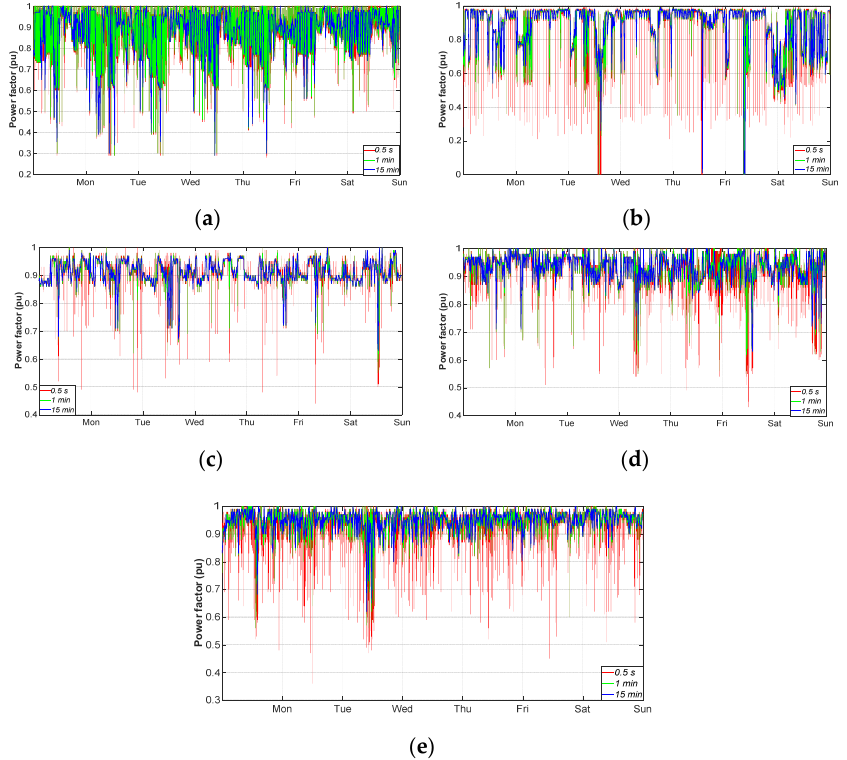
Figure 13. Weekly current distribution: ( a ) Household #1, ( b ) Household #2, ( c ) Household #3, ( d ) Household #4 and ( e ) Household #5.